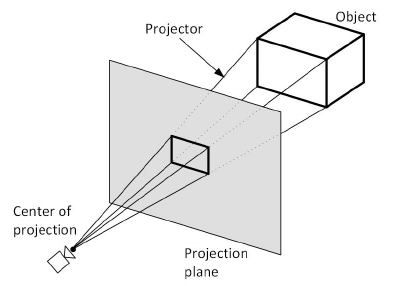
Figure 3. Obtaining a selected view of a three-dimensional scene